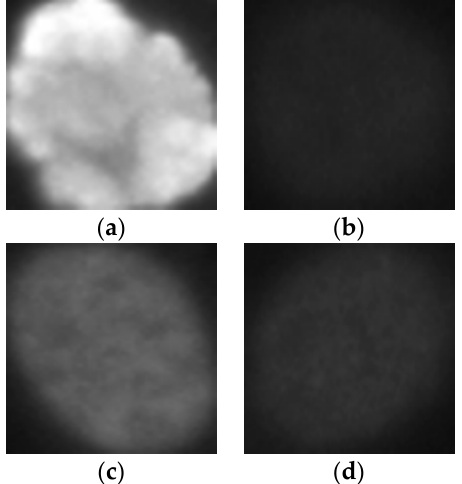
Figure 1. HEp-2 cellular images from the dataset. ( a ) The positive intensity fine speckled cell; ( b ) The negative intensity fine speckled cell; ( c ) The positive intensity homogeneous cell; ( d ) The negative intensity homogeneous cell.